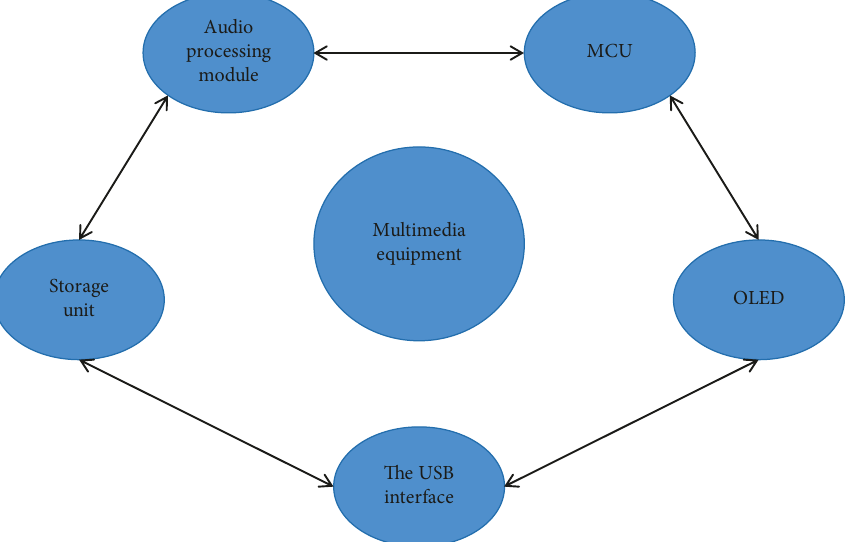
Figure 4: Composition of multimedia